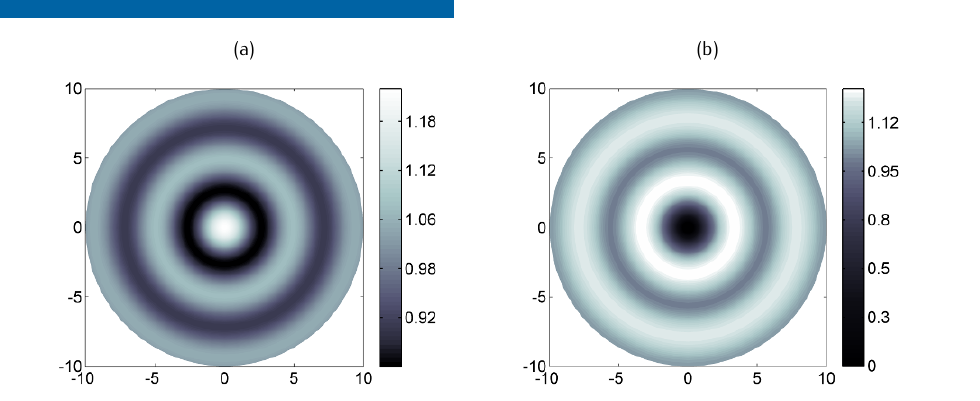
Figure 1. Self-similar function θ ( ξ ) computed for σ = 2 : (a) α = 0 . 1 ; (b) α = − 0 . 5 .